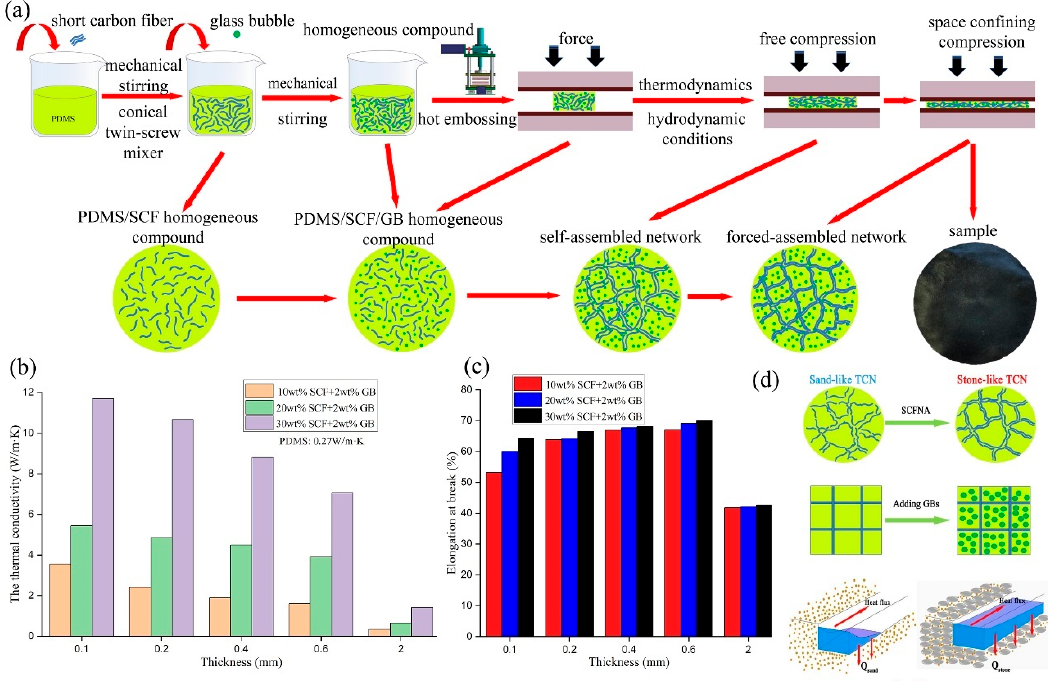
Figure 9. ( a ) Scheme of technological pathway of spatial confining forced network assembly (SCFNA) method and conventional compounding. ( b ) λ of PDMS/short-carbon-fiber (SCF) composites with different thicknesses. ( c ) The thermal and ( d ) electrical conductivity of PDMS/SCF composites [131].